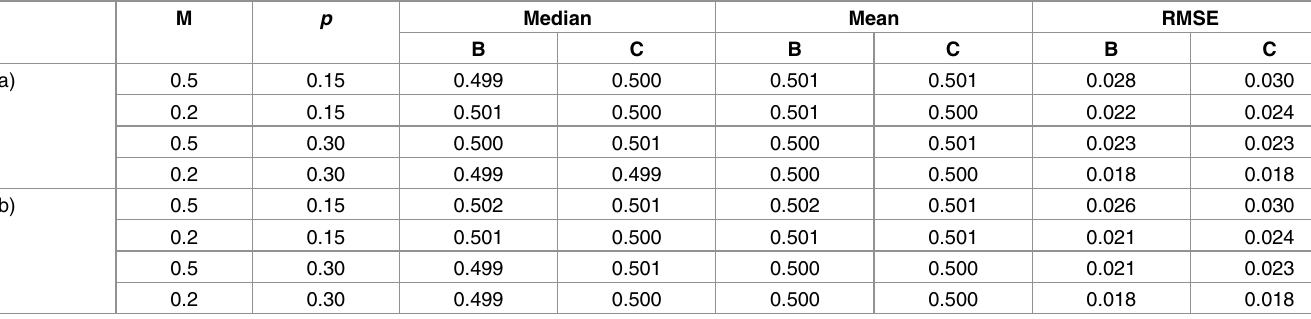
Table 1. Simulation check of the Bayesian(B) and classical (C) models.